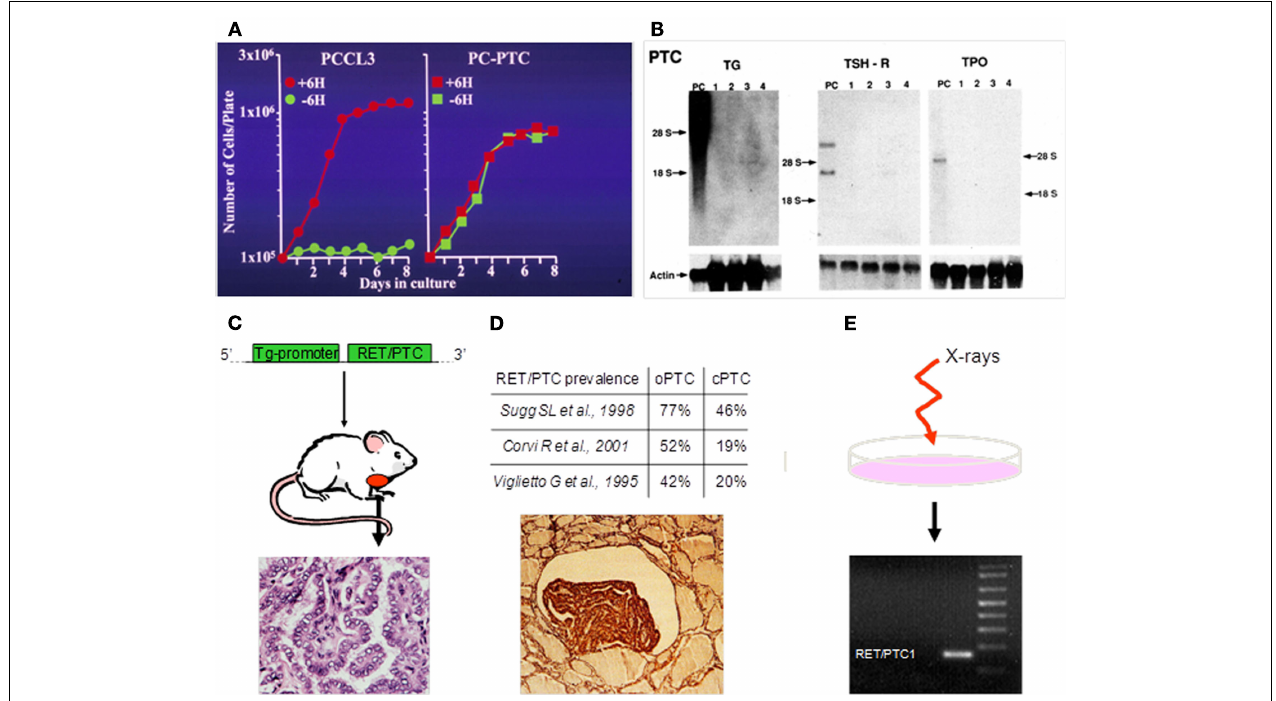
FIGURE 5 | Lines of evidence pointing to RET/PTC as a key first step in thyroid cancer pathogenesis. (A) RET/PTC expression causes TSH-independent proliferation in thyroid follicular cells. PCCL3: Parental well differentiated rat thyroid cell line. PC-PTC: PCCL3 cells stably expressing RET/PTC1. + 6H: Grown in the presence ofTSH. − 6H: Grown in the absence ofTSH (Modified from Santoro et al. (1993) with permission of the American Association for Cancer Research). (B) RET/PTC expression causes downregulation of differentiation markers in thyroid follicular cells. PC: Control parental PCCL3 cells. 1–4: Clones of PCCL3 cells stably expressing RET/PTC1.TG:Thyroglobulin.TSH-R:TSH